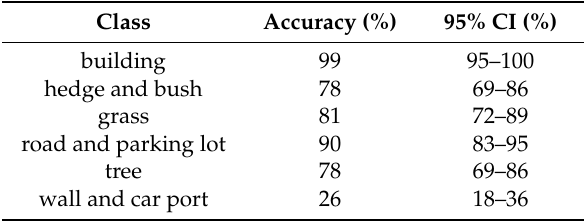
Table 5. User’s accuracy of the derived classes (adapted from